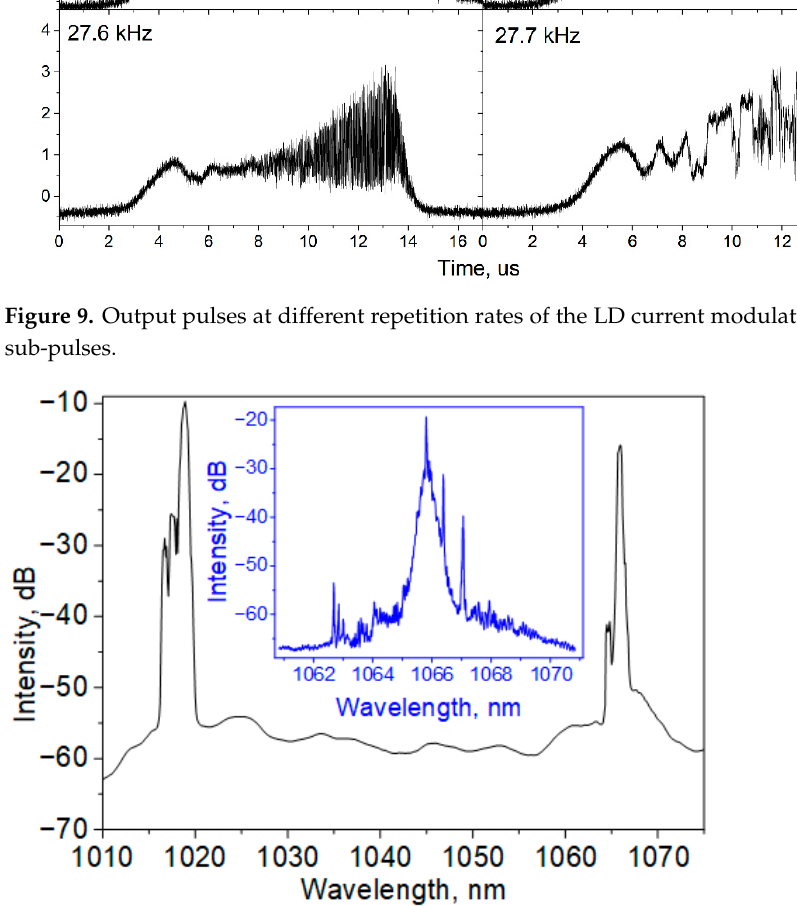
Figure 11. The 1st Stokes ( a ) and the 2nd Stokes ( b ) pulse shapes at gain modulation (40 W pump power, repetition rate 27.22 kHz). Inset: zoomed sub-pulses. 3.0